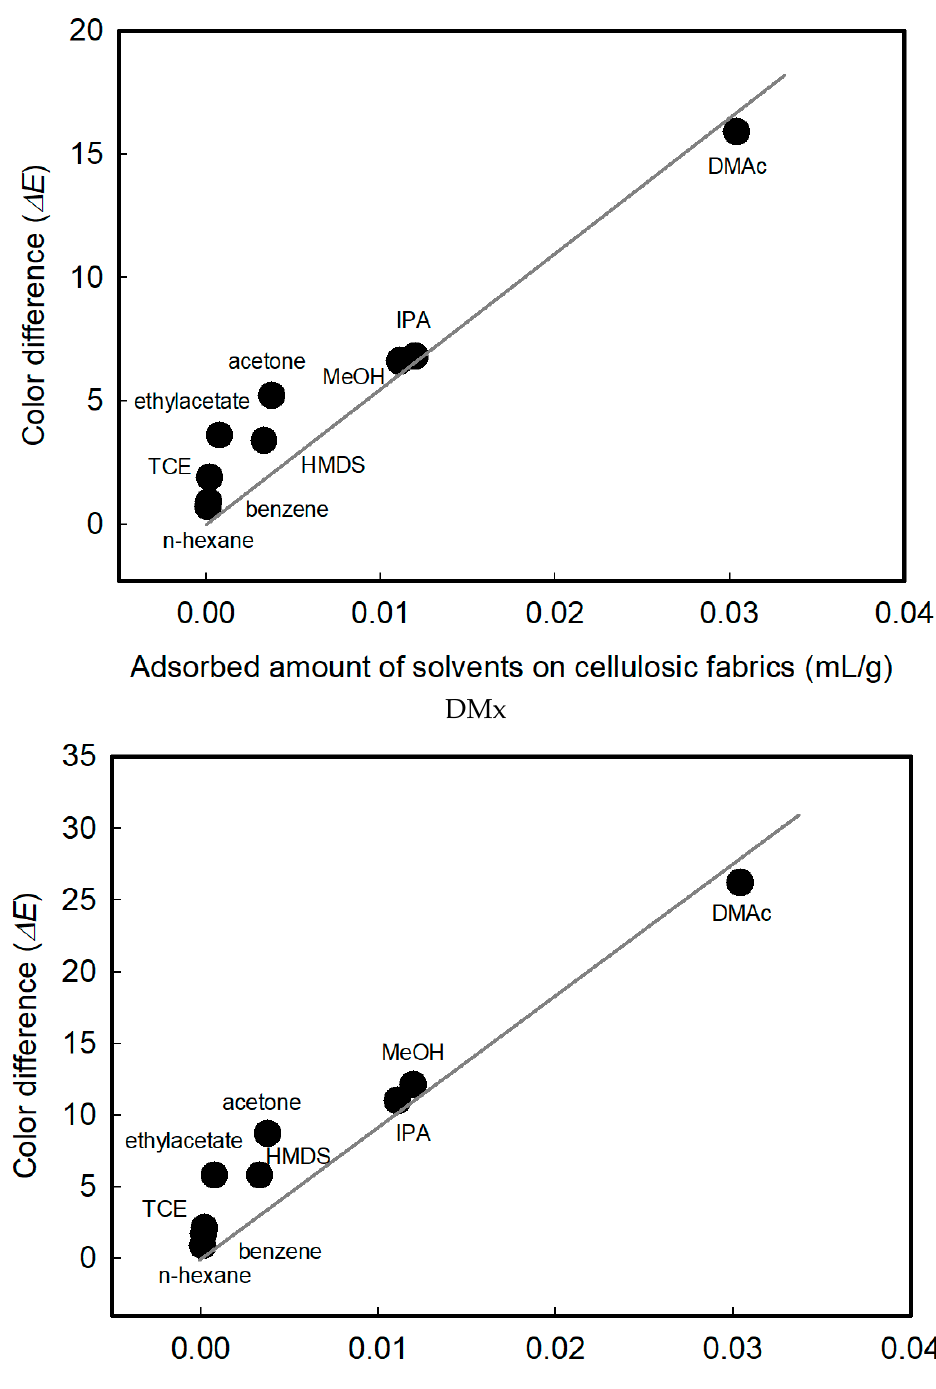
Figure 10. Relationship between the adsorption amounts of solvents on cellulosic fabrics and color difference before and after exposure to solvents.